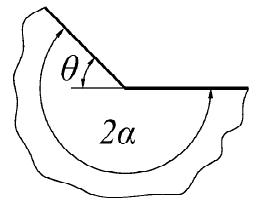
Figure 10. Characteristic angles 2 α and θ of the sharp corner.